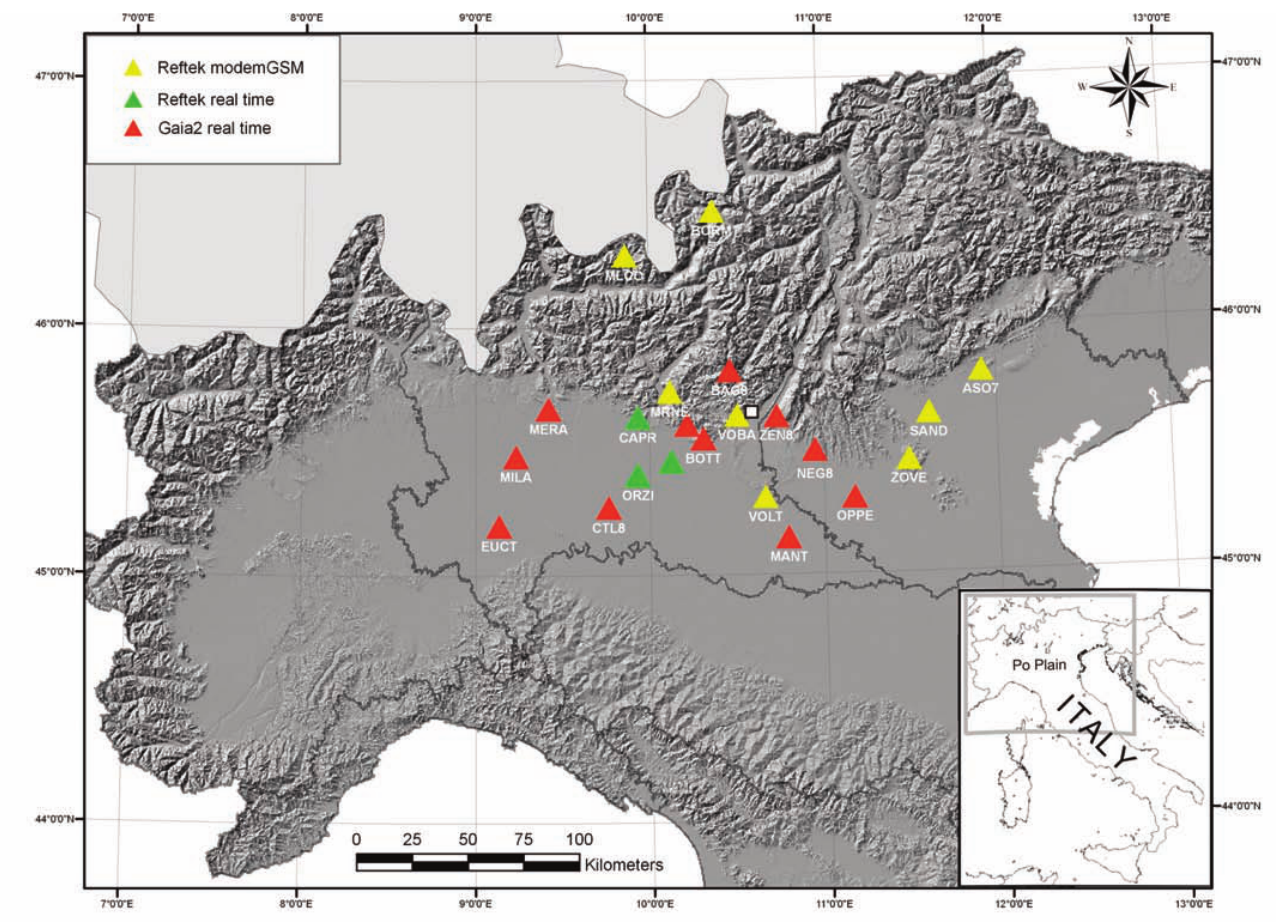
Figure 1. RAIS strong-motion network. Different colors indicate stations characterized by different recording systems or different data-transmission types (as indicated). White square, epicenter of the November 24, 2004, M